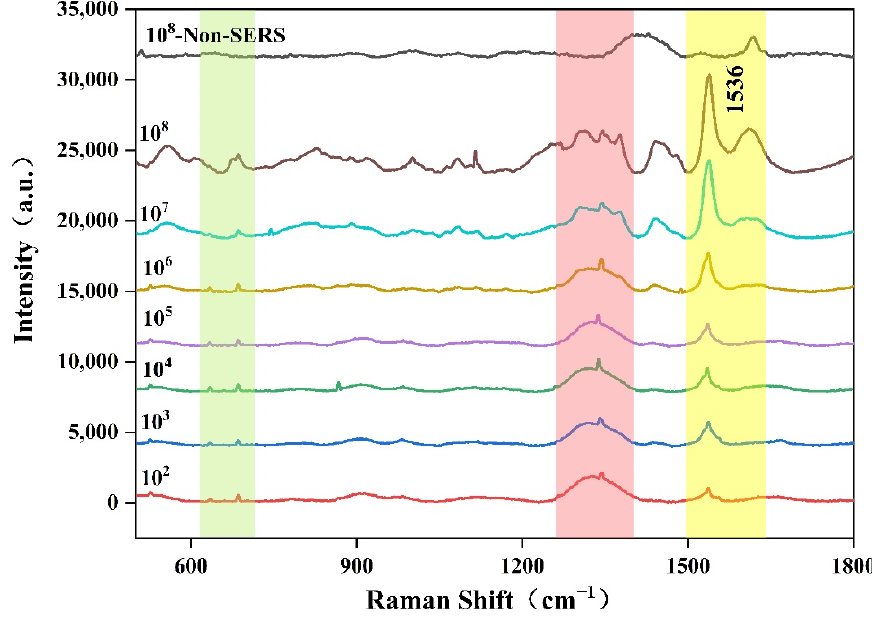
Figure 6. SERS spectra of different concentrations of Aspergillus flavus spore suspension.